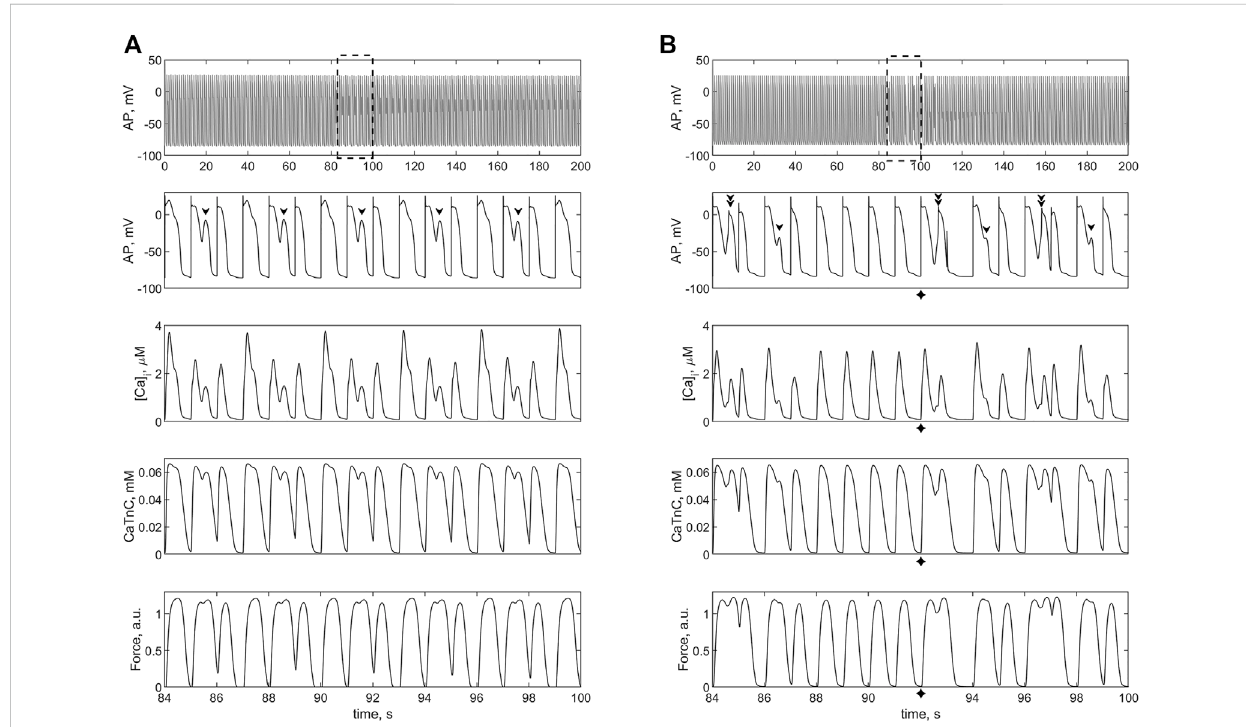
FIGURE 8 Isometric contractions of a cardiomyocyte at a length of 90% L max in case of a twofold increase (compared to the norm) of the L-type calcium currentconductance. (A) simulationinthe TP+M model(i.e.,without fi broblasts).Proarrhythmicdisturbancesintheisolatedcardiomyocyteoccurinthe form of EADs (shown by arrows), not extrasystoles. (B) simulation in model 2 with electromechanical interaction with 2 fi broblasts at ɡ gap = 3.0 nS. Extrasystoles (shown by crosses) start at 92 s. Upper panels: cardiomyocyte APs in the time interval from 0 to 200 s at a pacing rate of 1 Hz. Other panels: details of APs, Ca 2+ transients ( [Ca] i ), concentration of calcium-troponin complexes ( CaTnC ) and isometric force signals ( Force ) in the interval from 84 to 100 s marked by dashed rectangles in the upper panels.